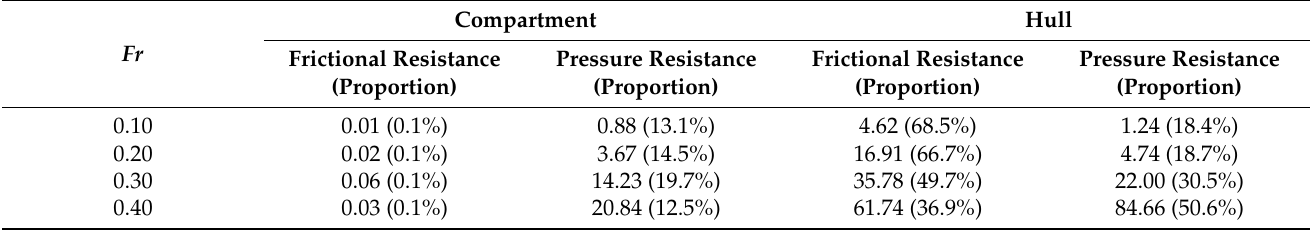
Table 14. Resistances of compartment and hull and proportions to the total resistance under the asymmetric flooding case (unit: N).